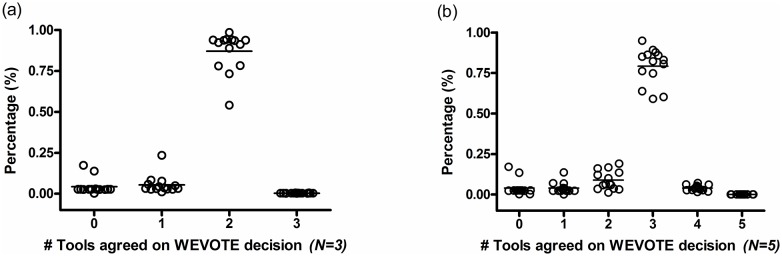
The percentage distribution of the number of individual tools that support the WEVOTE decision for the 14 datasets.Here, 0 means that the read was not classified by any tools, 1 means that one tool supports the WEVOTE assigned taxon for the read, and so on. A = 3 in the case of (a) means that all the 3 tools support WEVOTE on its assigned taxon for the corresponding read, A = 5 in case of (b) means that all the used 5 tools support WEVOTE on its assigned taxon for the corresponding read.